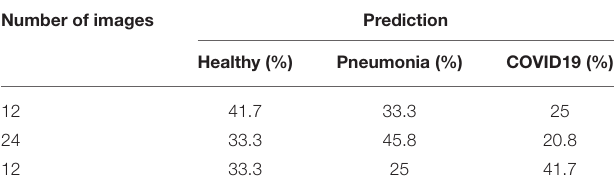
TABLE 3 | DenseNet121 performance for multiclass (Haritha et al., 2020a). Number of